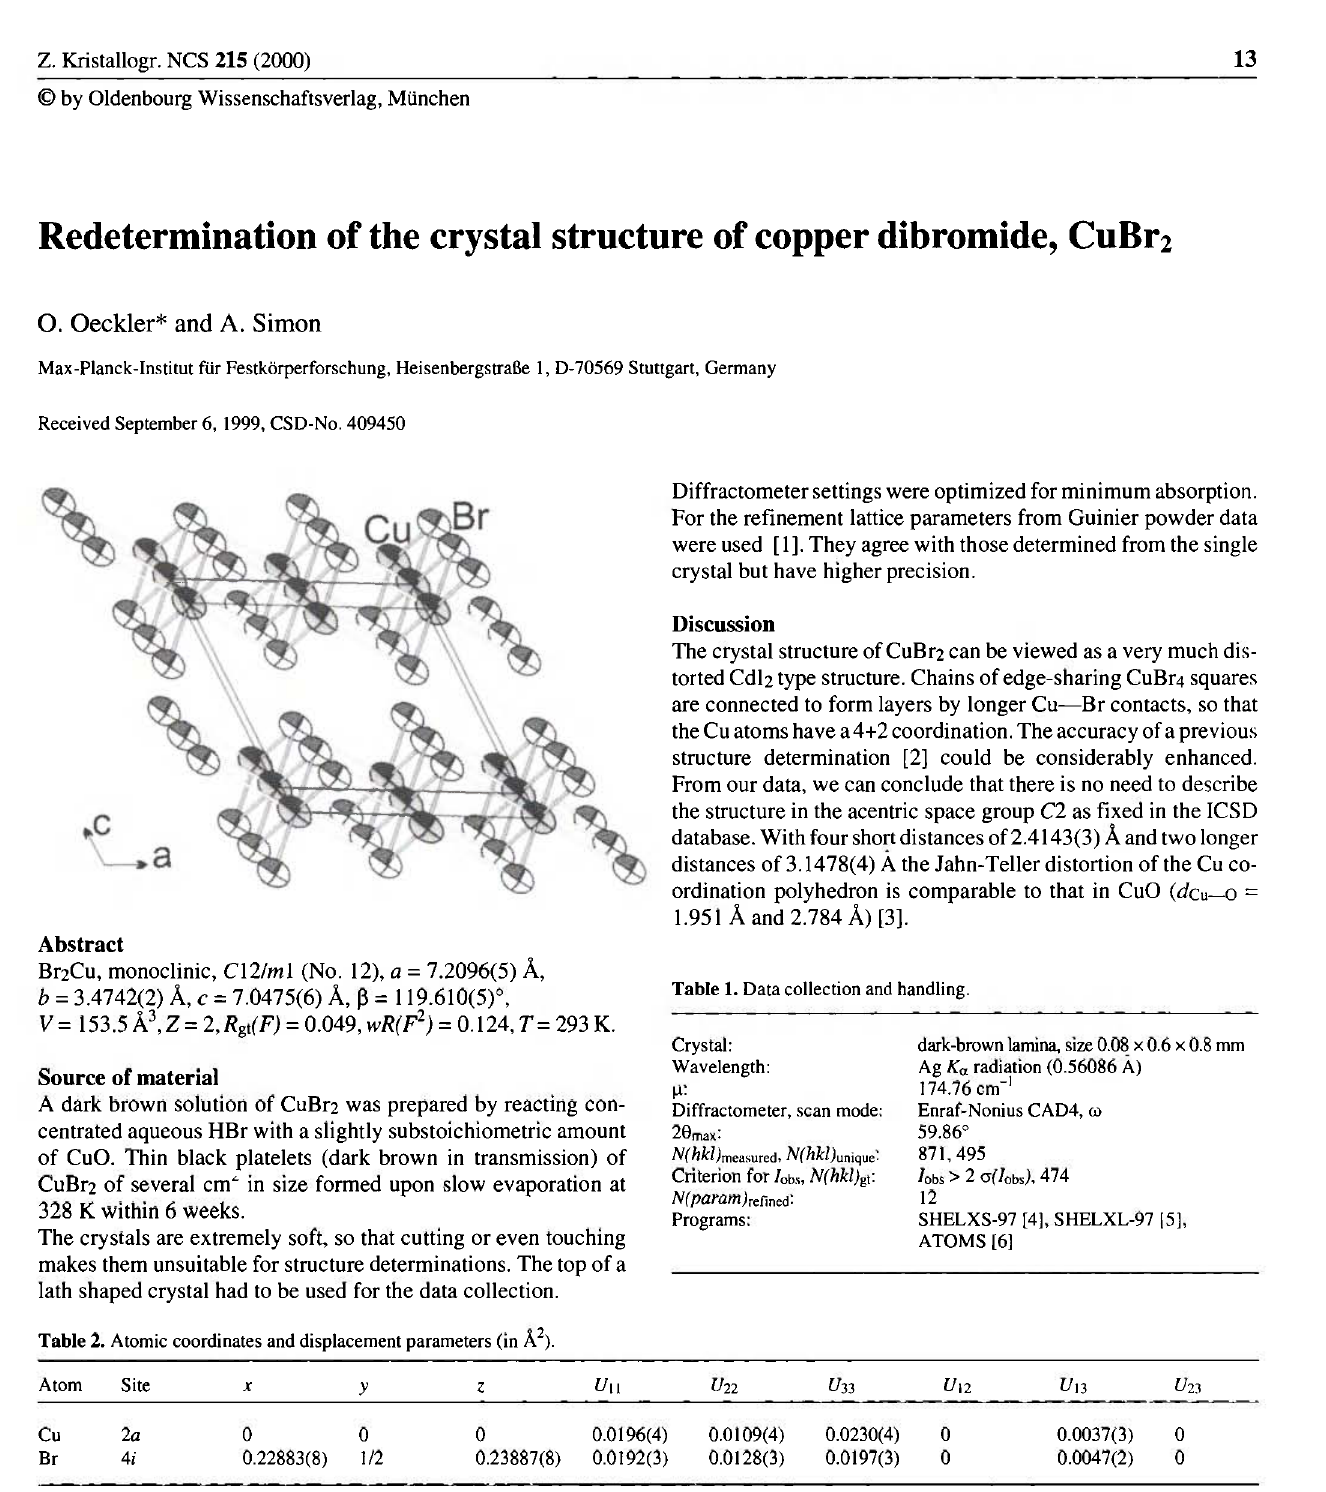
Table 2. Atomic coordinates and displacement parameters (in Ä 2 ). Atom